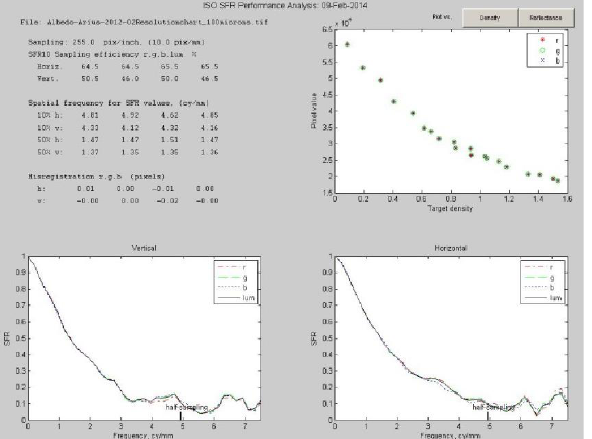
Figure 17. Spatial Frequency Response evaluation for Team 2.